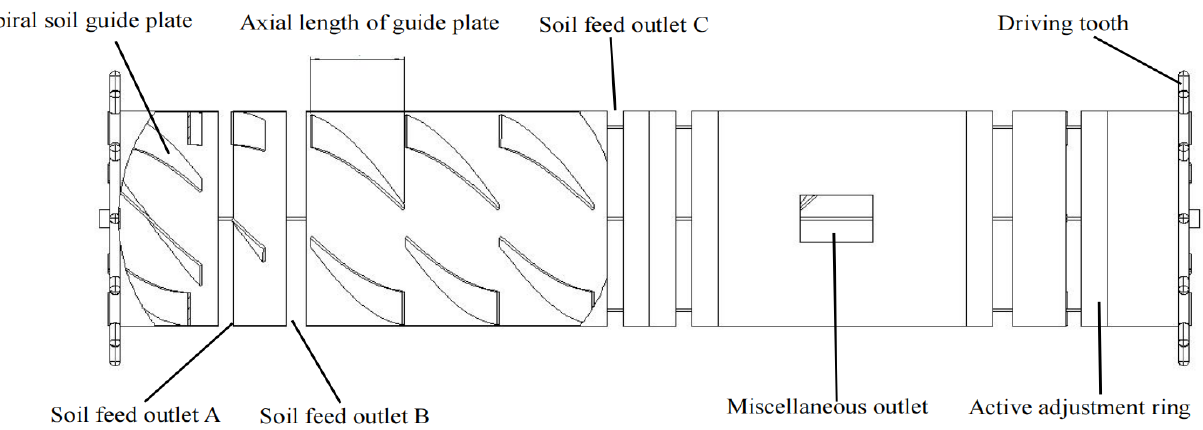
Figure 3. Structural diagram of earth covering